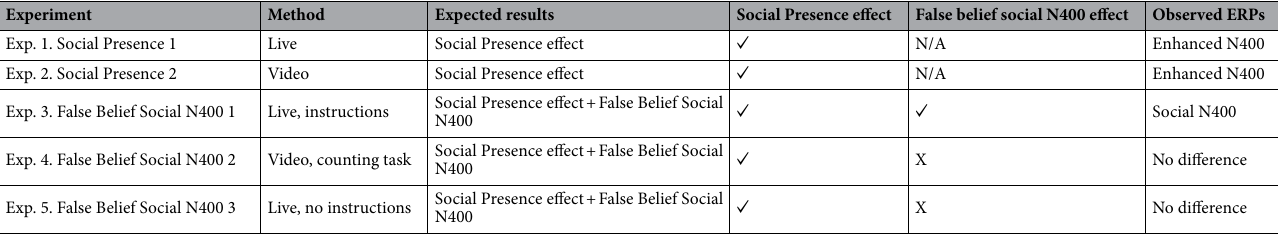
Table 1. Summary of expected and observed results in all five